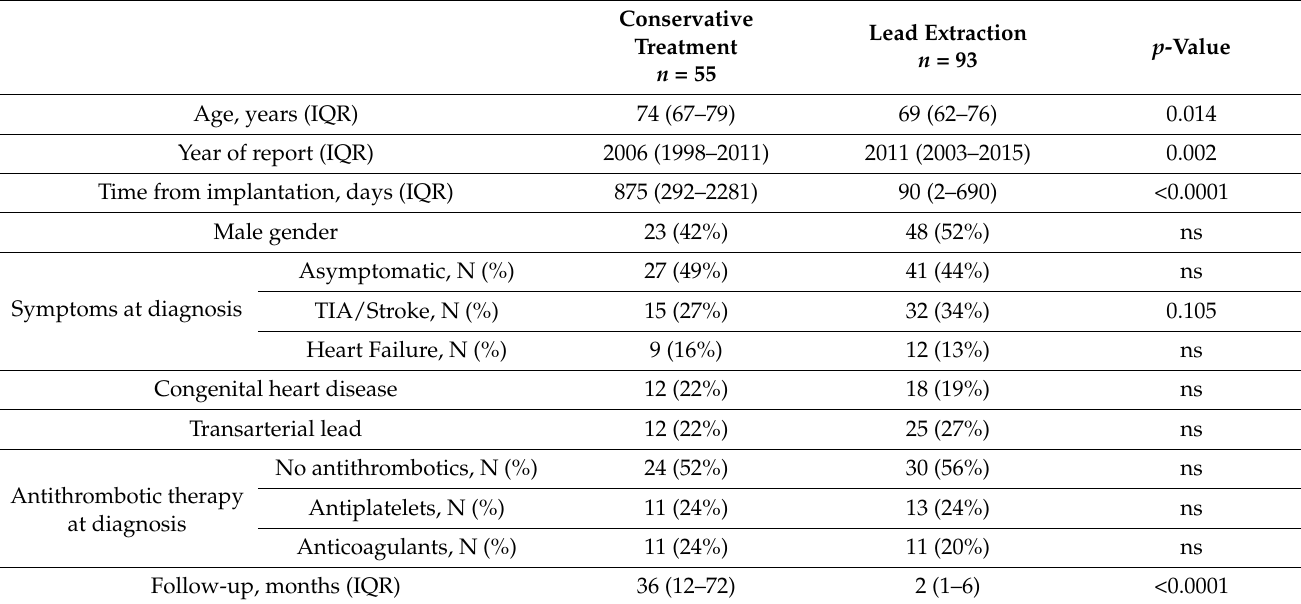
Table 4. Comparison between patients treated conservatively or with lead